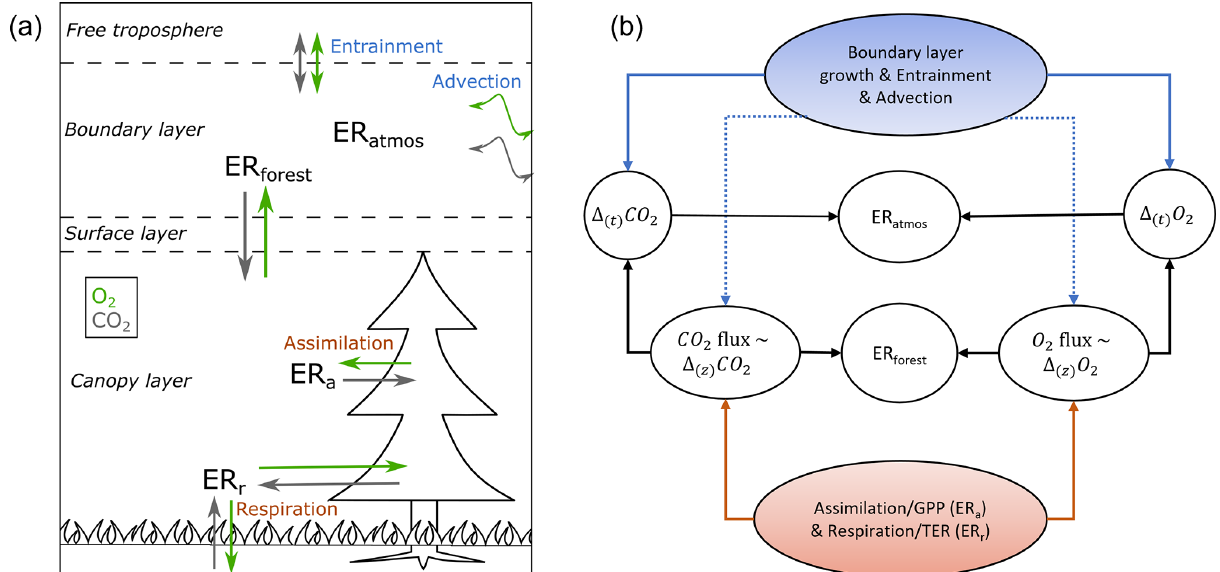
Figure 1. Schematic overview of the different O 2 : CO 2 exchange ratio (ER) signals, measured and analysed in and above a forest, influenced by the different O 2 and CO 2 fluxes and meteorological processes (a) , together with a more detailed look on which processes influence the different ER signals (b) . Panel (a) shows the direction of the surface fluxes during the day in the surface layer, which includes the roughness sublayer and the inertial sublayer. During the night the direction of the O 2 and the CO 2 surface fluxes are the other way around. The ER of the atmosphere (ER atmos ) is determined from the change over time ( (cid:49) ( t ) ) in the O 2 and CO 2 concentration measurements, and the ER of the forest (ER forest ) is calculated from the surface fluxes of O 2 and CO 2 , which are inferred from ( ∼ ) the vertical gradient ( (cid:49) ( z ) ). ER a represents assimilation processes that influence the gross primary production (GPP) flux, and ER r represents respiration processes that influence the total ecosystem respiration (TER) flux. Panel (b) shows the connections between the processes, measurements, and the ERs. Dotted lines indicate smaller influences of the processes that are connected to it compared to solid